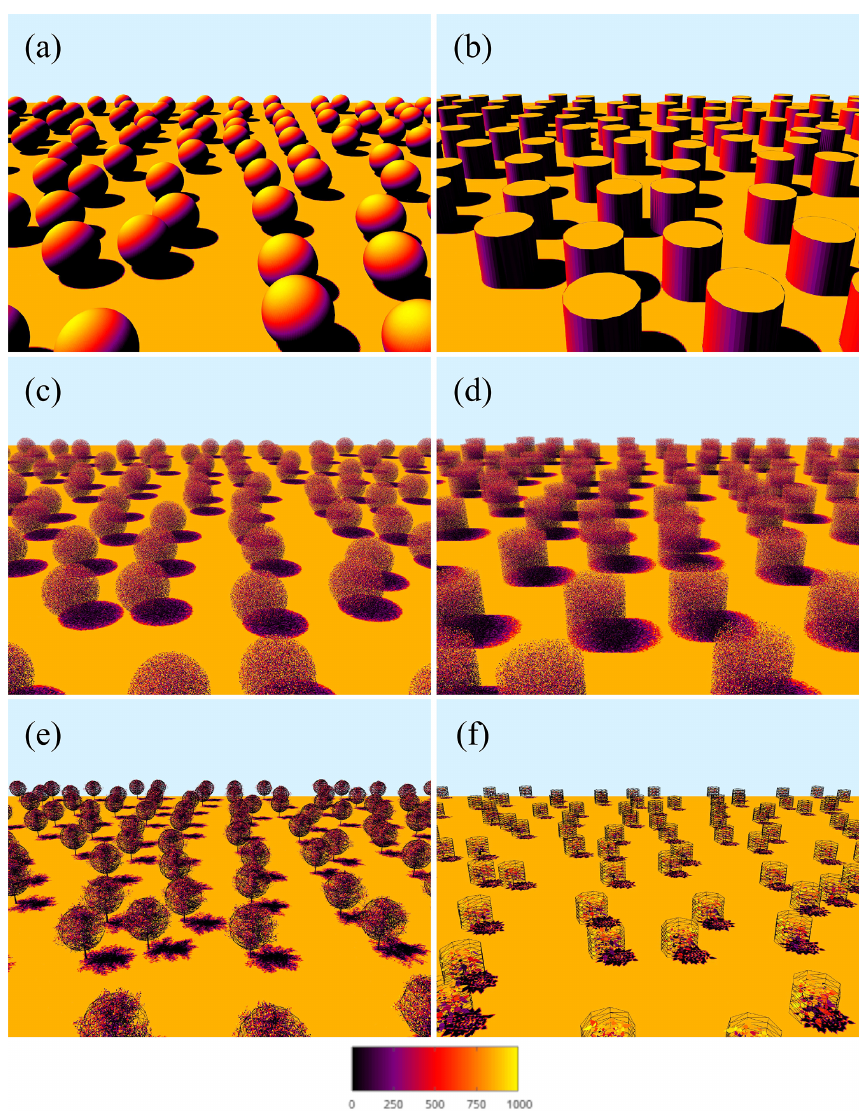
Figure 3. Visualization of virtual canopy geometries: (a) Case #1 – solid spheres, (b) Case #2 – solid cylinders, (c) Case #3 – uniform vegetation in spherical crowns, (d) Case #4 – uniform vegetation in cylindrical crowns, (e) Case #5 – tree canopy, and (f) Case #6 – non- tree plant canopy (potato). Wireframe meshes in (e) and (f) show the assumed crown envelope based on a best fit to the exact radiation interception. Surfaces are colored using a pseudocolor mapping of the modeled intercepted radiation flux (Wm − 2